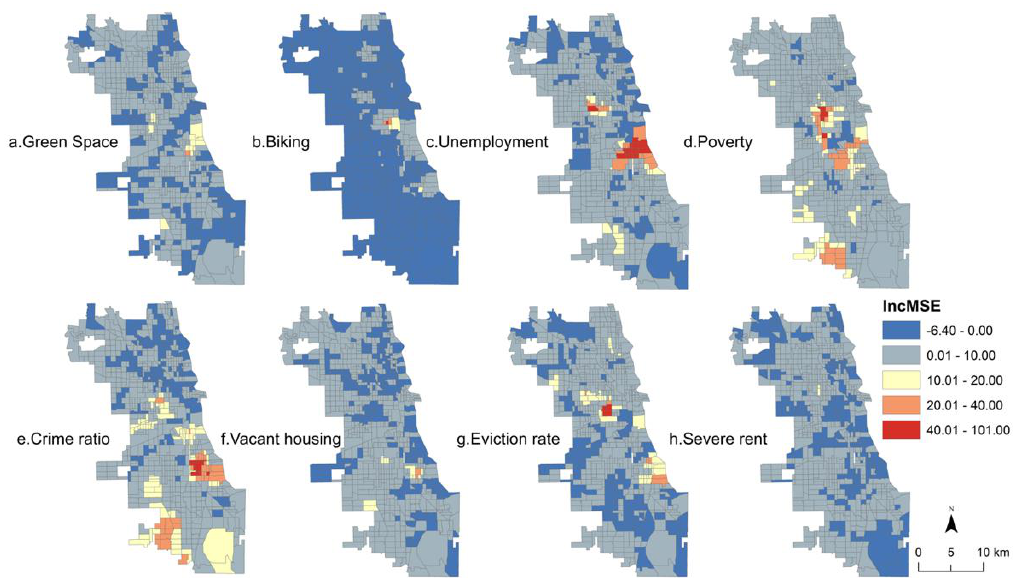
Figure 3. Spatial variation of local feature importance (IncMSE) of green spaces, biking, crime ratio, poverty, vacant housing, unemployment, severe rent, and eviction rate using the geographically random forest model. Negative values indicate features with no predictive contribution.